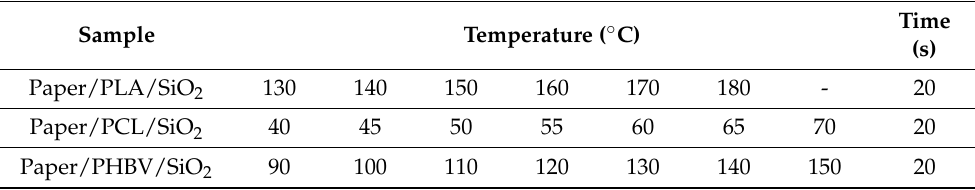
Table 2. Conditions employed for the thermal post-treatment of Paper/PLA/SiO 2 , Paper/PCL/SiO 2 , and Paper/PHBV/SiO 2